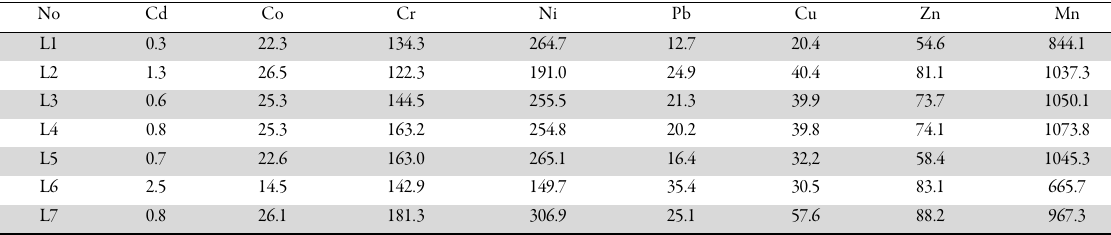
Table 2. Results of heavy metal analysis of soil samples (ppm)